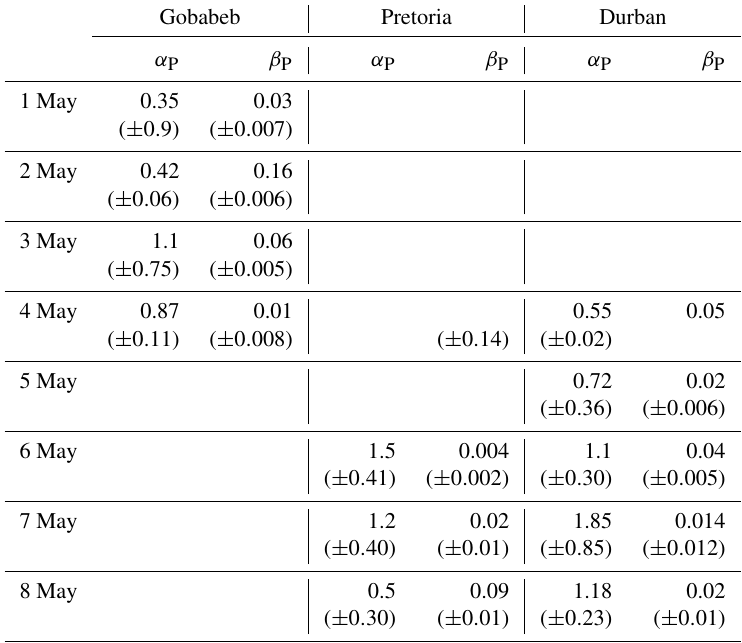
Table 5. The mean and standard deviation for the plume-isolated Angström exponent and turbidity from 1 to 8 May for the Gobabeb, Pretoria, and Durban sites. The empty grids indicate that no observations were